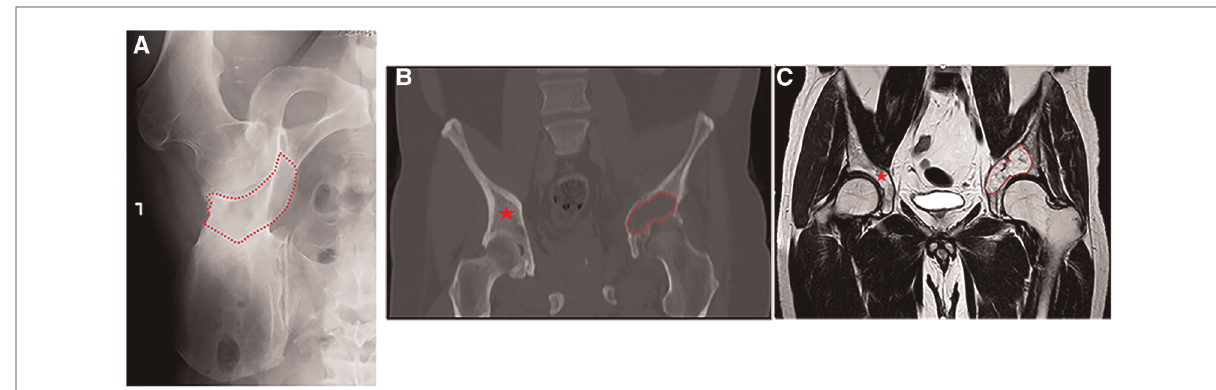
FIGURE 2 ( A ) plain anterior-posterior (AP) radiograph of a left hemipelvis, showing high-grade chondrosarcoma of the acetabulum with the destruction of the medial acetabular wall. The red dotted line delimits the radiolucent area created by the bone tumor. ( B,C ) A coronal computed tomography (CT)